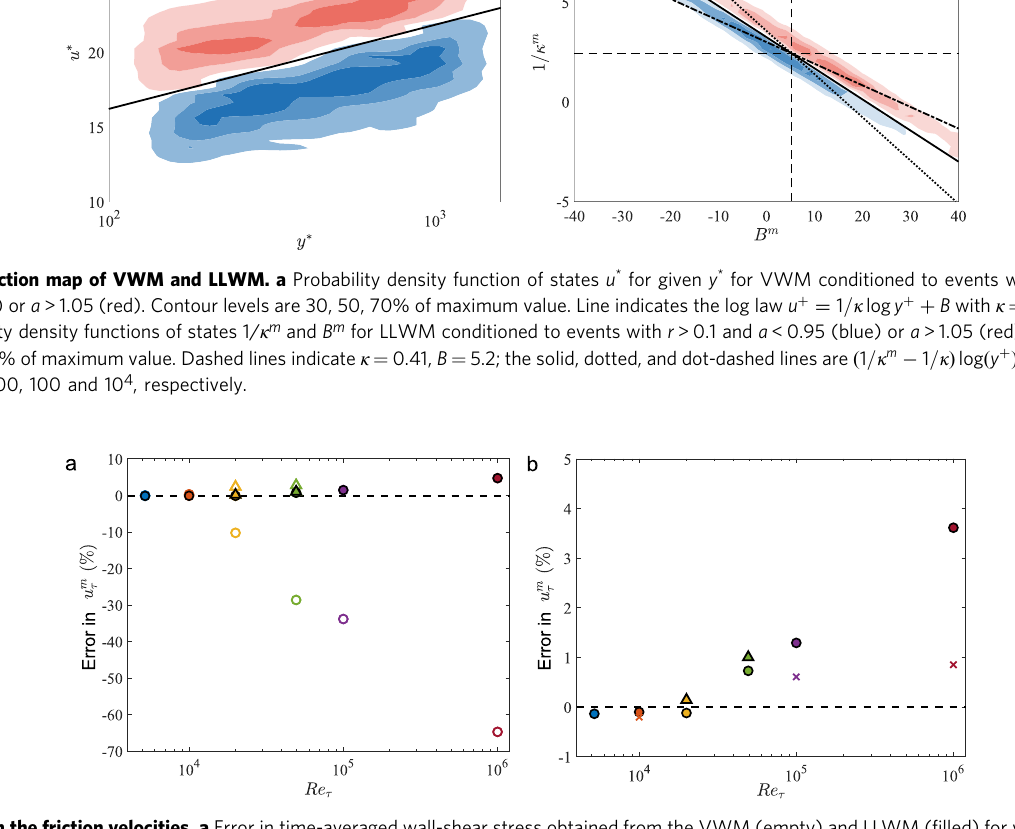
Fig. 3 Errors in the friction velocities. a Error in time-averaged wall-shear stress obtained from the VWM (empty) and LLWM ( fi lled) for various Reynolds numbers. Circles indicate the standard grid with Δ y = 0.05 and triangles indicate re fi ned cases. b Zoomed in the version of ( a ) for LLWM with error in EQMW (crosses) for three Reynolds numbers.